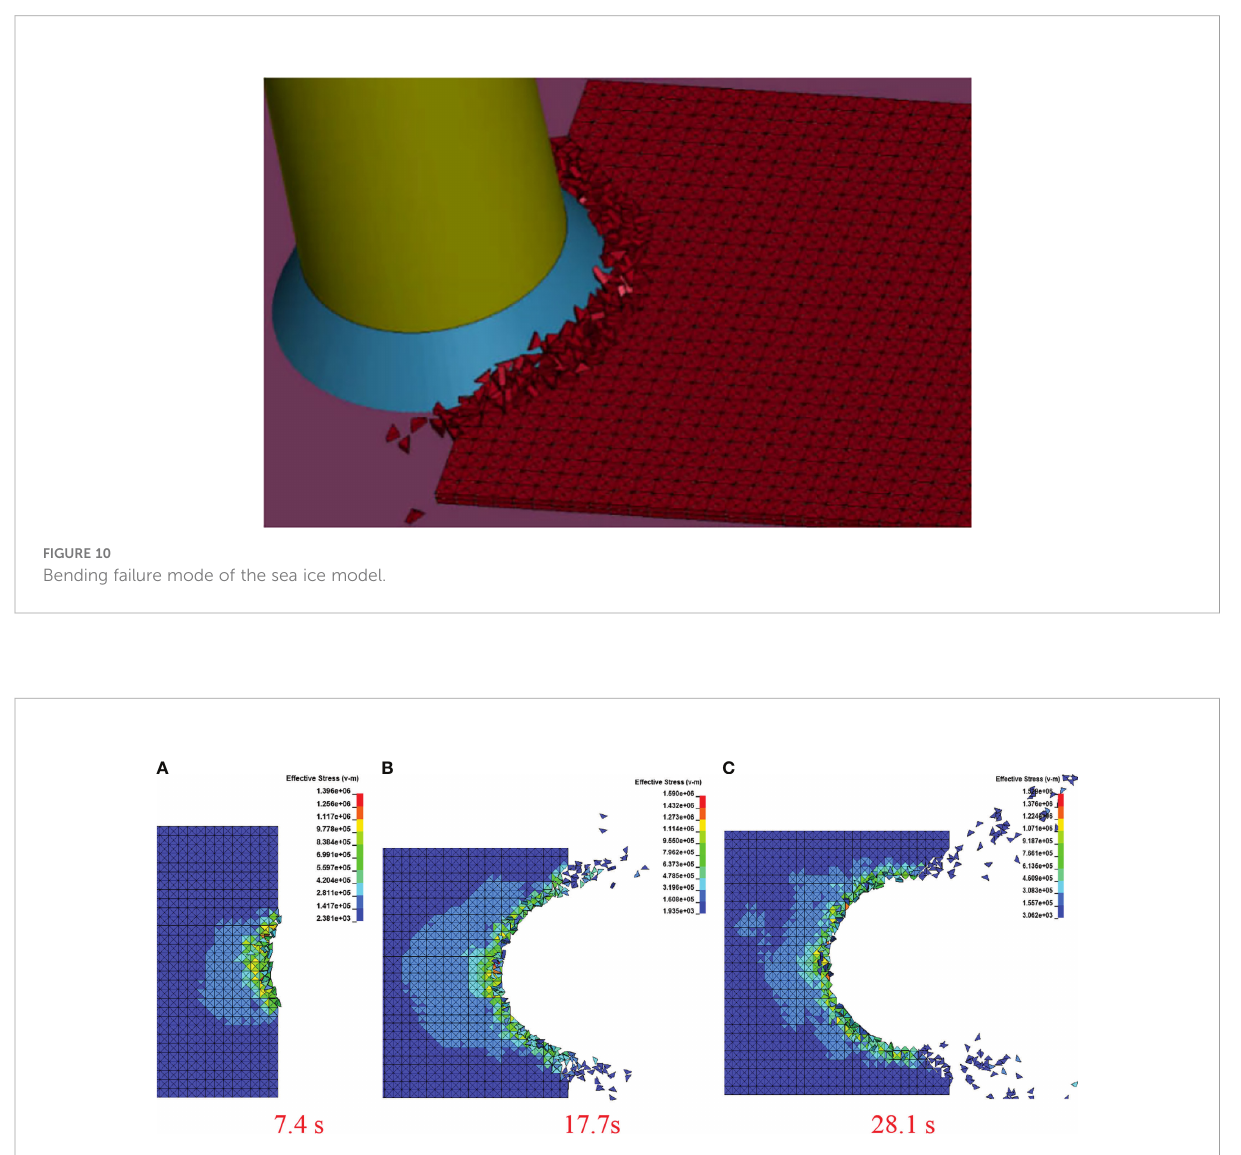
FIGURE 11 Ice stress distribution at different time steps. (A) at 7.4 s. (B) at 17.7 s. (C) at 28.1 s.